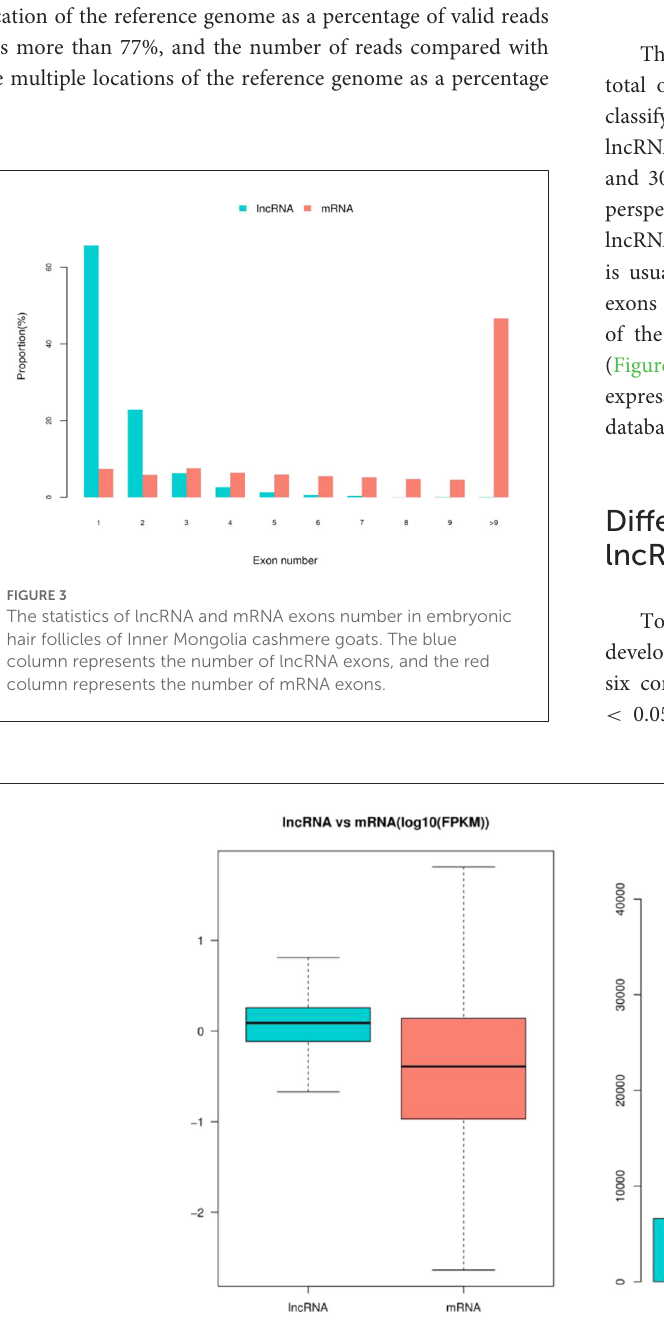
FIGURE4 Expression levels of lncRNA and mRNA in embryonic hair follicles of Inner Mongolia cashmere goat. The blue column represents the average expression level of lncRNA, and the red column represents the average expression level of mRNA.